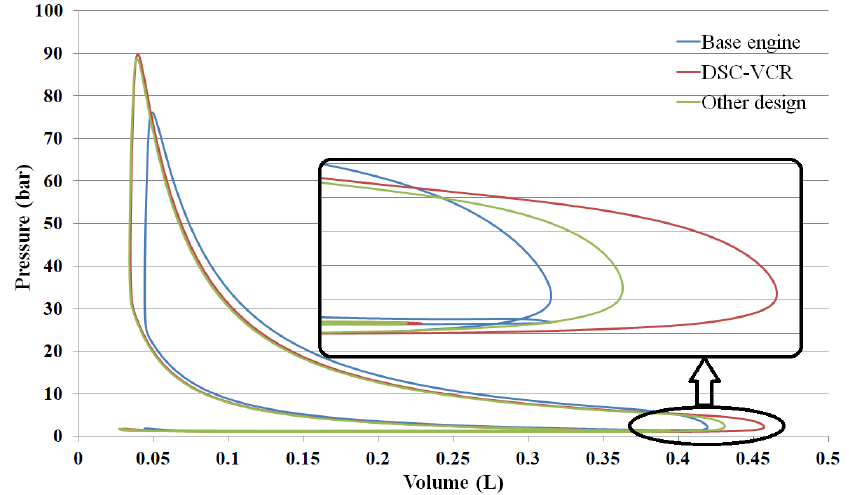
Figure 16. Comparison of the in-cylinder temperature and ON for different engines in case 1.